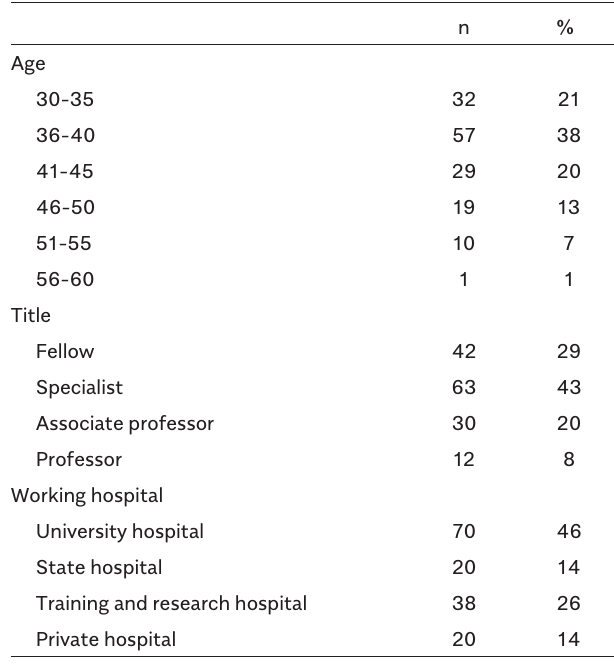
Table 1. Demographic Characteristics of the